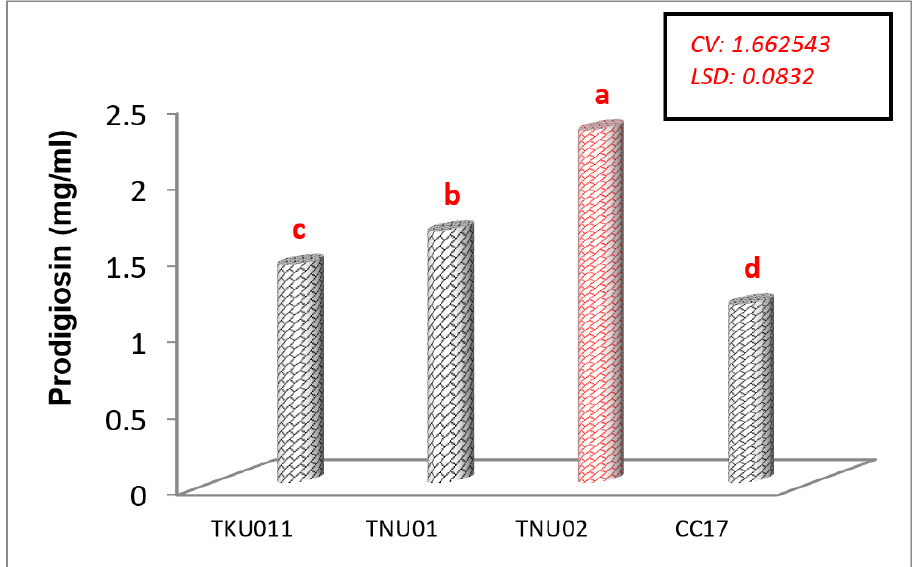
Figure 3. Screening of potential strain for prodigiosin (PG) production. The experiments were conducted in triplicate and data were analyzed via simple variance (ANOVA), and then Fisher’s LSD tests at p = 0.01 were performed. Values with the different letters are significantly different. LSD—Least Significant Difference; CV—Coefficient of Variation.